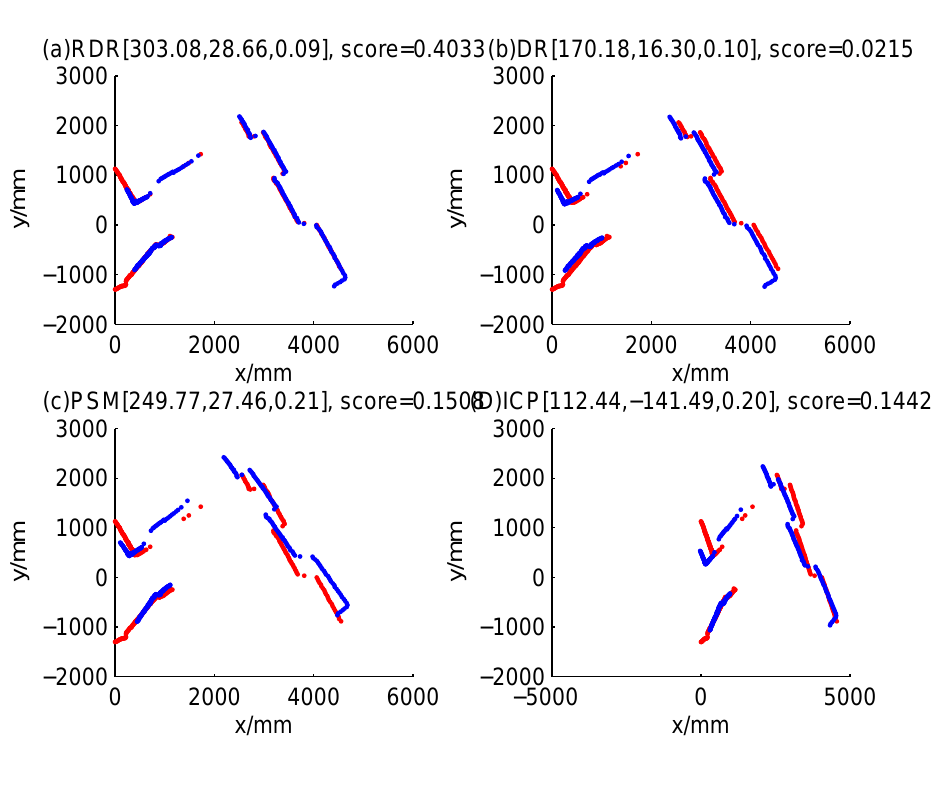
Figure 16. Robust dead reckoning result for Case 2b (time Step 8).